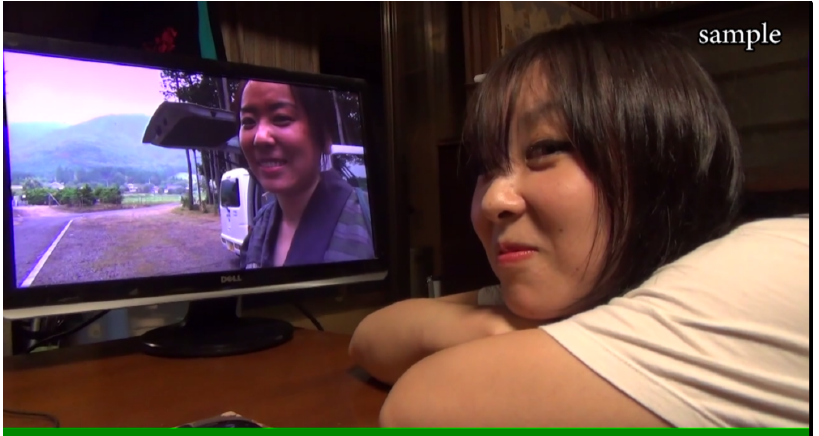
Fig. 9. One Yasukawa encounters another. After Gamushara